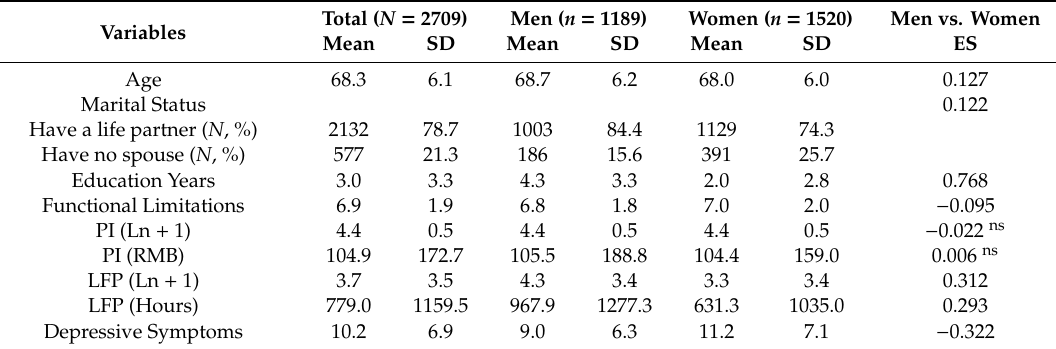
Table 1. Description of analytic variables.